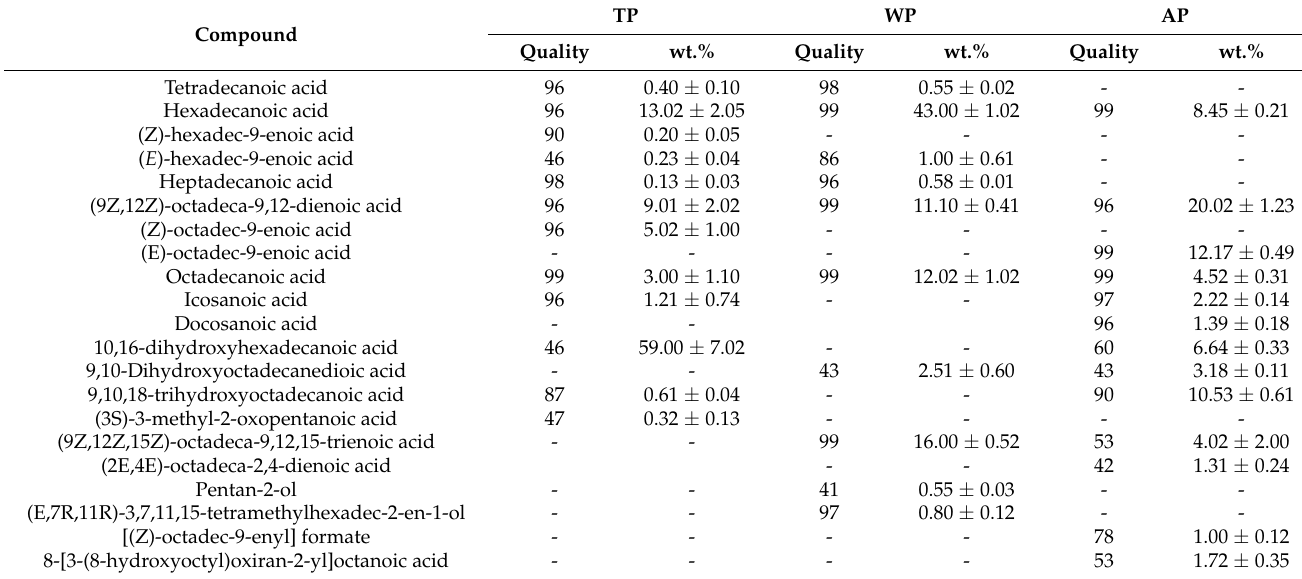
Table 4. Composition of cutin monomers obtained from the studied peel wastes, expressed as